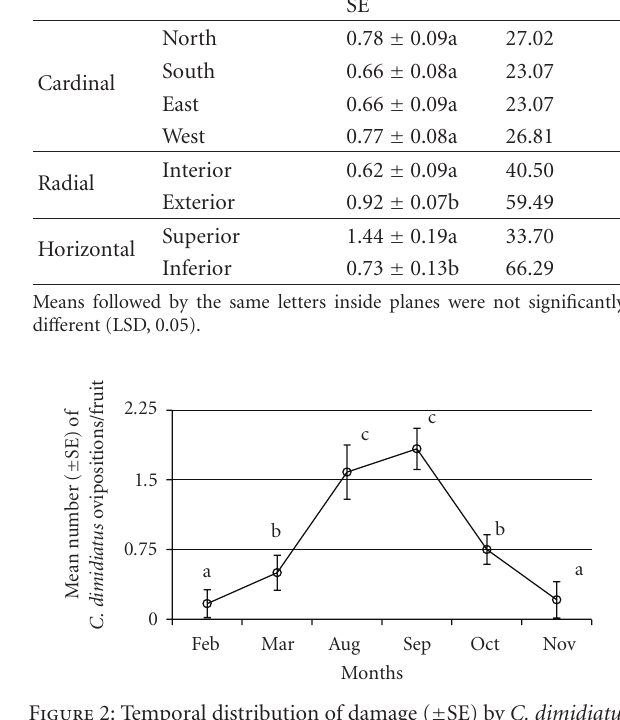
Figure 2: Temporal distribution of damage ( ± SE) by C. dimidiatus in guava trees in Aguascalientes, Mexico. Months with di ff erent letters are significantly di ff erent (LSD,